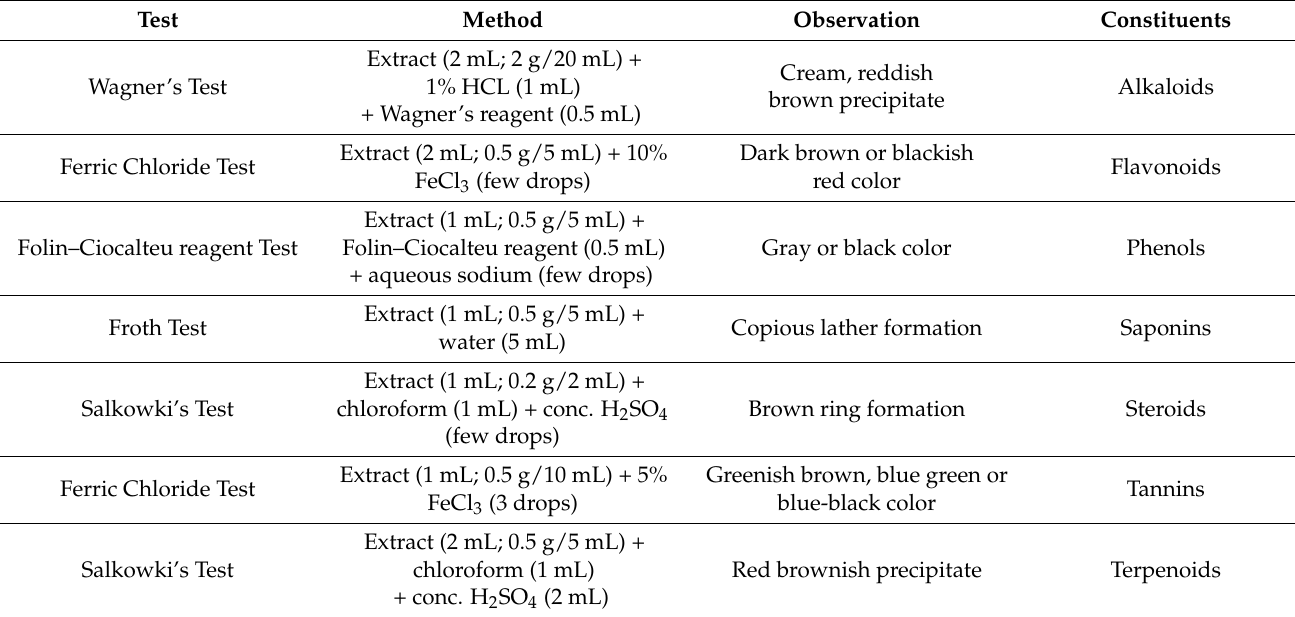
Table 1. Qualitative phytochemical screening methods for O. basilicum leaf